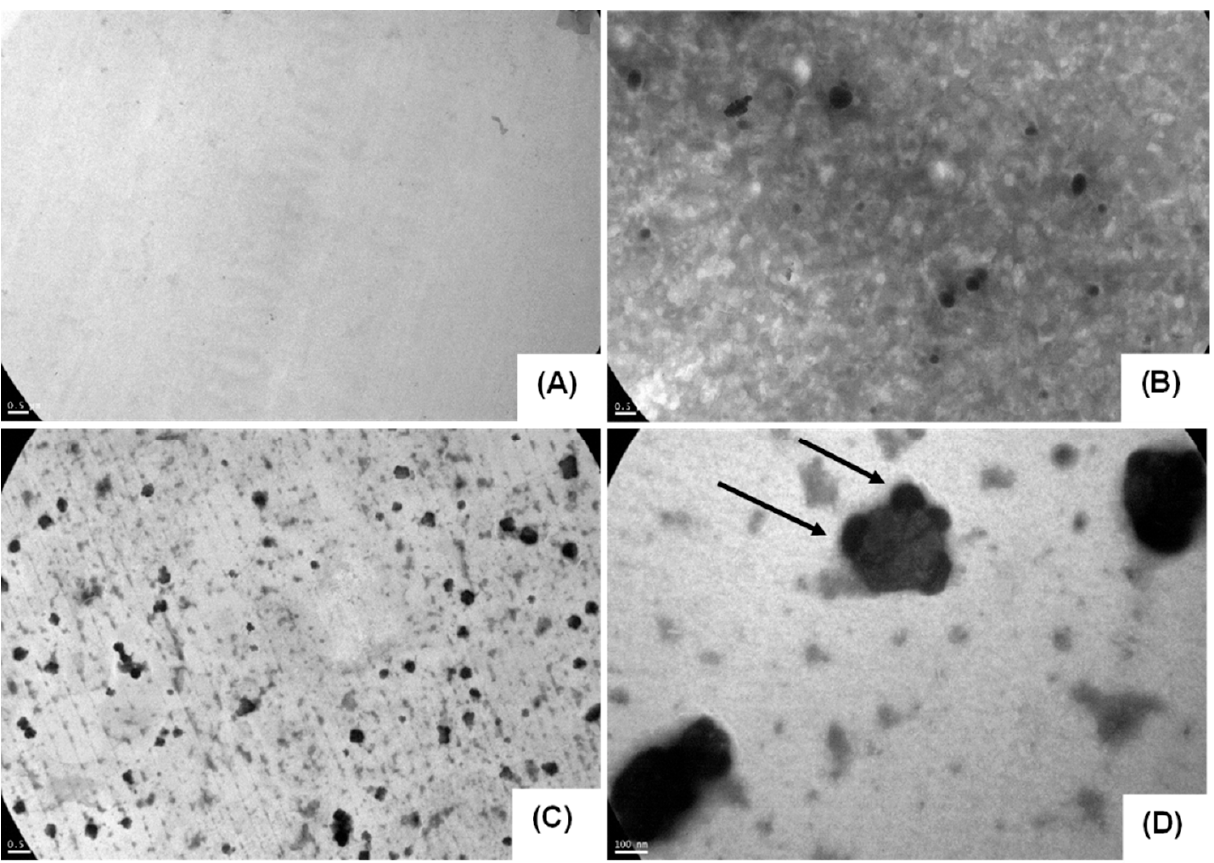
Figure 1. TEM images of ( A ) free-probe, ( B ) free-PPL, ( C ) PPL-probe, and ( D ) 85,000 × magnification of PPL-probe. Scale bar: ( A – C ) 500 nm and ( D ) 100 nm. Arrows in ( D ) point out the probe on the surface of PPL.